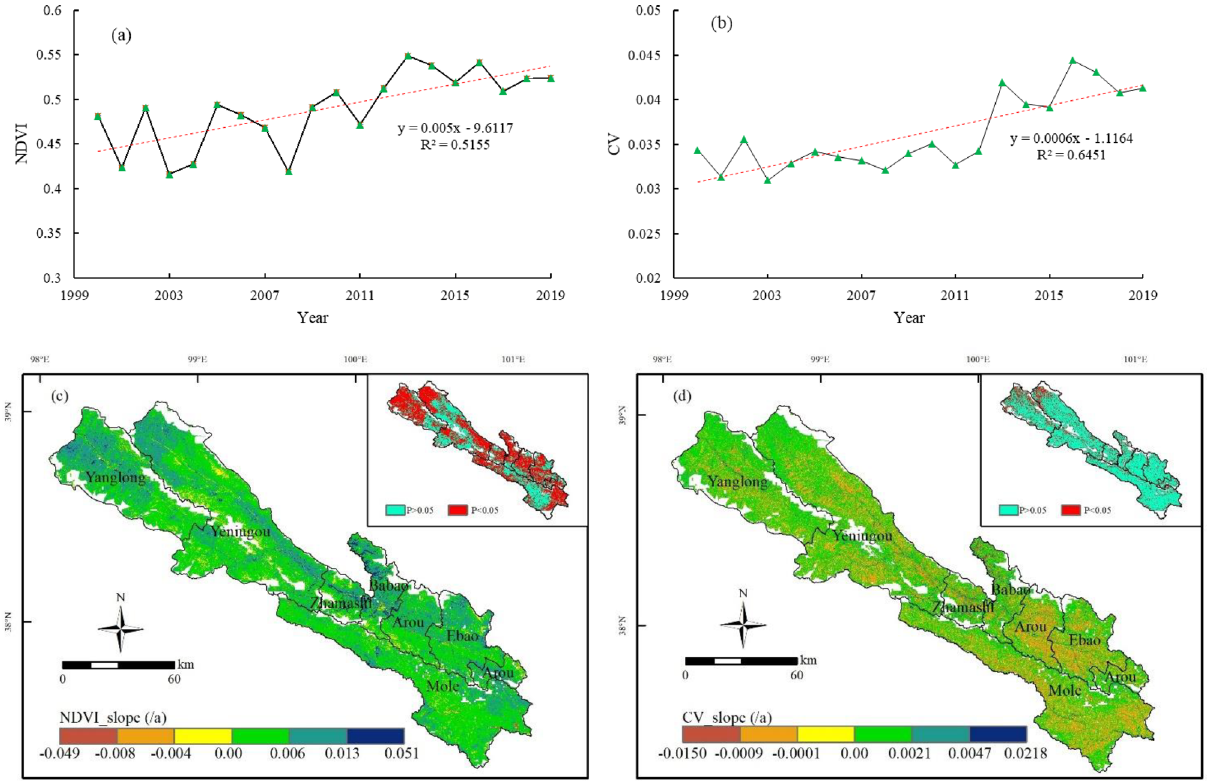
Figure 2. ( a ) and ( b ) Temporal variation in normalized difference vegetation index (NDVI) and coefficient of variation of NDVI (CV NDVI ) between 2000 and 2019. ( c ) and ( d ) Spatial variation in normalized difference vegetation index (NDVI) and coefficient of variation of NDVI (CV NDVI ) between 2000 and 2019. The map was generated by ArcGIS 10.2, URL: https:// www. esri. com.